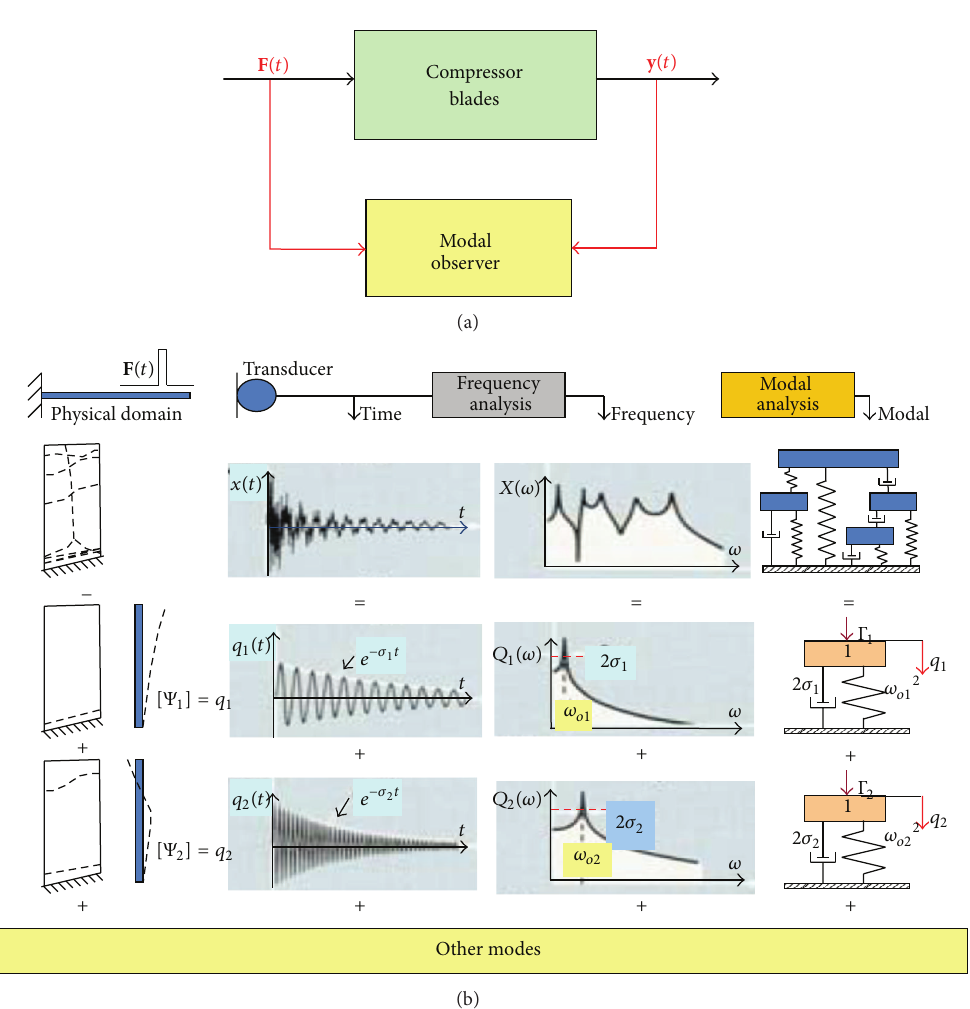
Figure 16: Blade health and mechanical properties analysis using the experimental modal